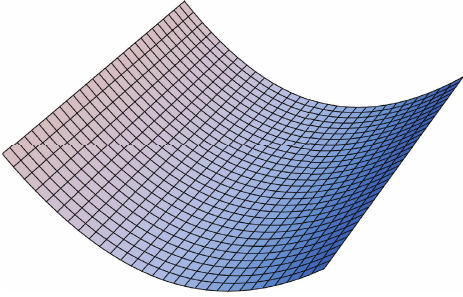
Figure 5: A spacelike parabolic sphere (cid:3) K (cid:7) 0 (cid:4)